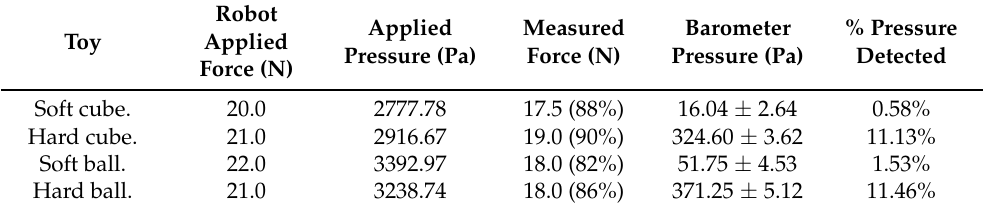
Figure 8. Barometric squeezing detection: ( a ) soft cube, ( b ) soft ball, ( c ) hard cube, ( d ) hard ball. Table 2. Squeezing